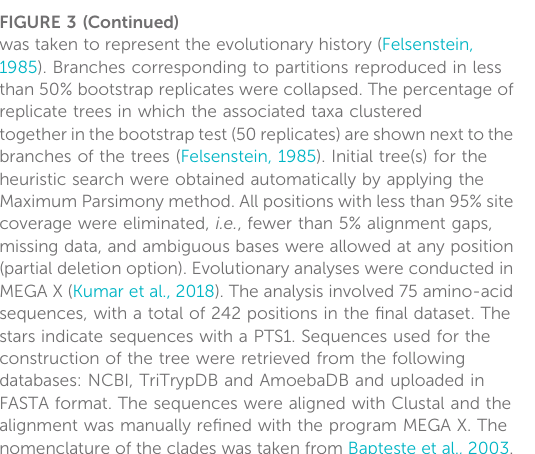
FIGURE 3 Relationships between phosphofructokinase (PFK) sequences. The evolutionary history of PFK sequences was inferred by from their amino-acid sequences by using the Maximum Likelihood method and JTT matrix-based model (Jones et al., 1992). For each enzyme analysed, a bootstrap consensus tree inferred from 500 replicates (Felsenstein, 1985)